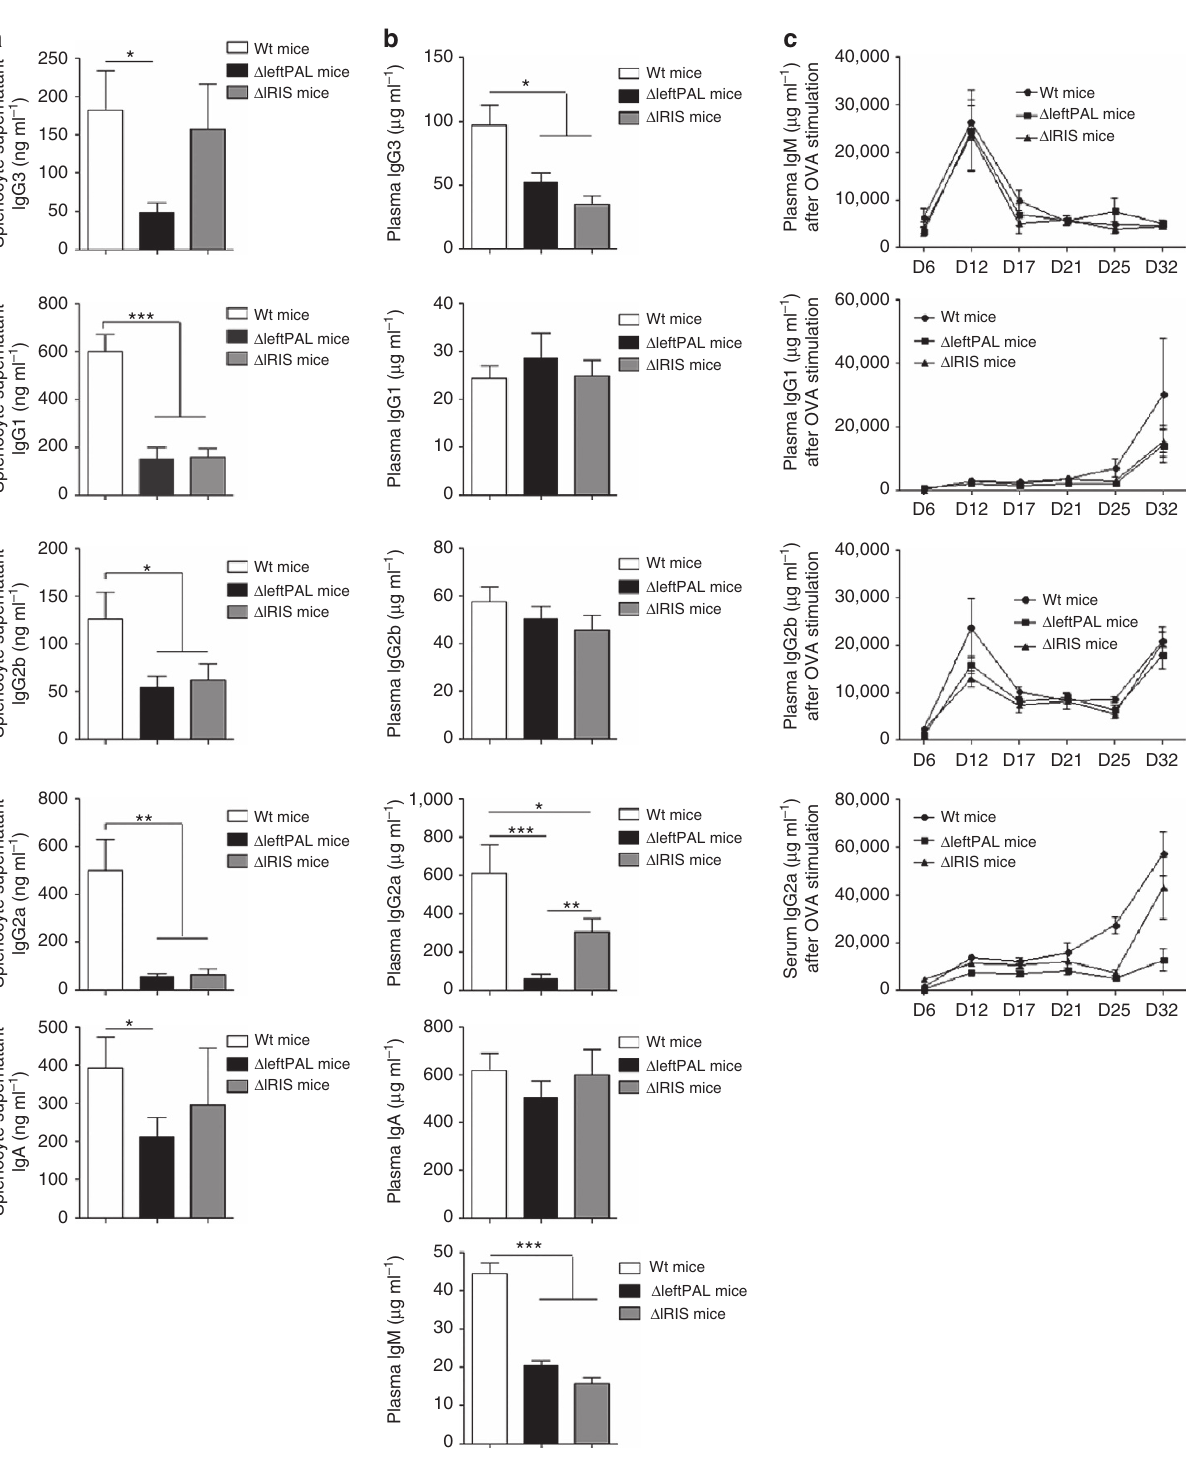
NATURE COMMUNICATIONS|7:10730|DOI: